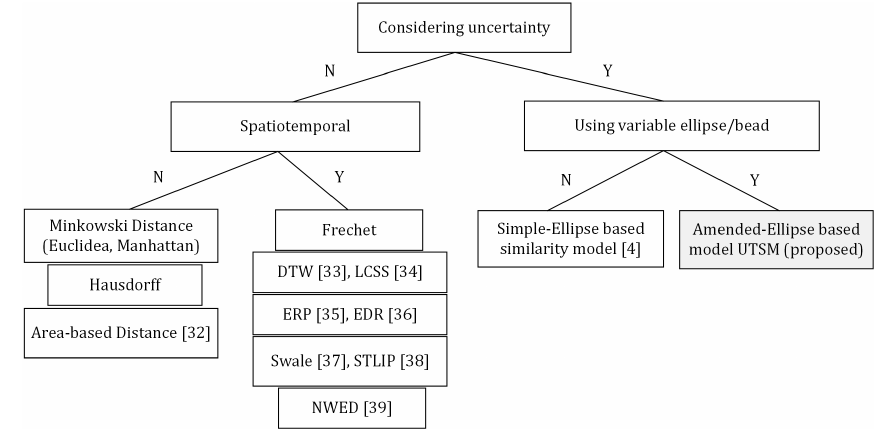
Figure 3. Trajectory similarity measure